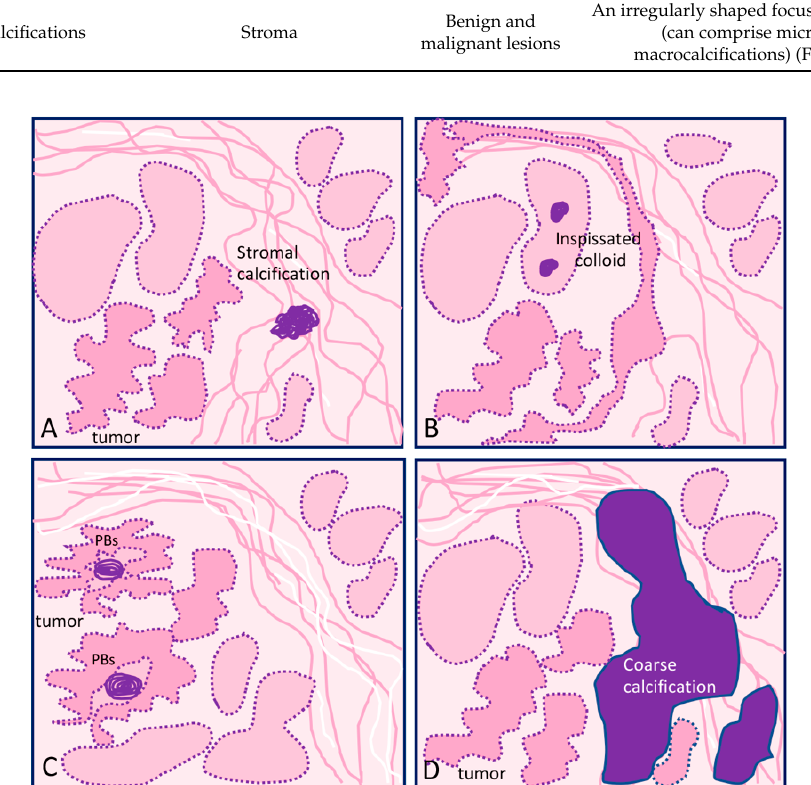
Figure 1. Graphical representation of the di ff erent types of calcification in thyroid tissue sections: ( A ) focus of stromal calcification (in purple color) in the tumor stroma, ( B ) inspissated colloid calcified, ( C ) psammoma bodies (PBs) (in purple color) located in the papillary thyroid carcinoma present inside lymphatic vessels or in the stalk of the papillae, and ( D ) coarse macrocalcification (in purple color). Shapes in pink correspond to non-tumor thyroid; shapes in deeper pink correspond to tumor thyroid.